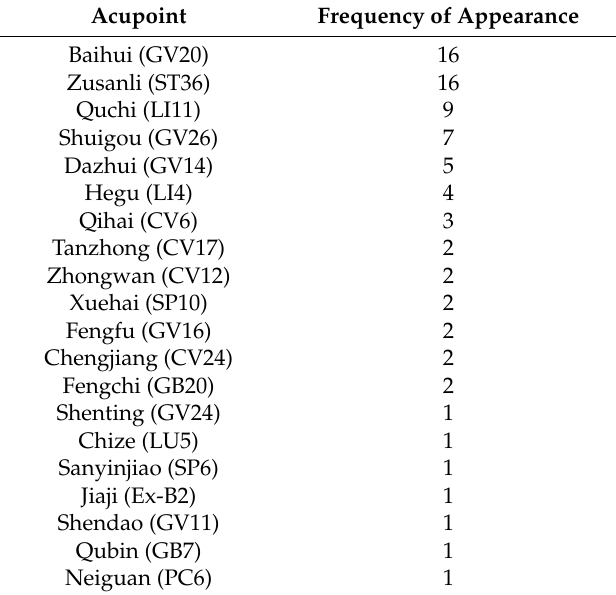
Table 1. Summary of main acupoints selected in the reviewed